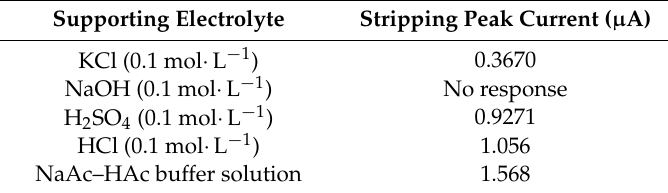
Table 1. Effect of different types of supporting electrolytes on the stripping peak